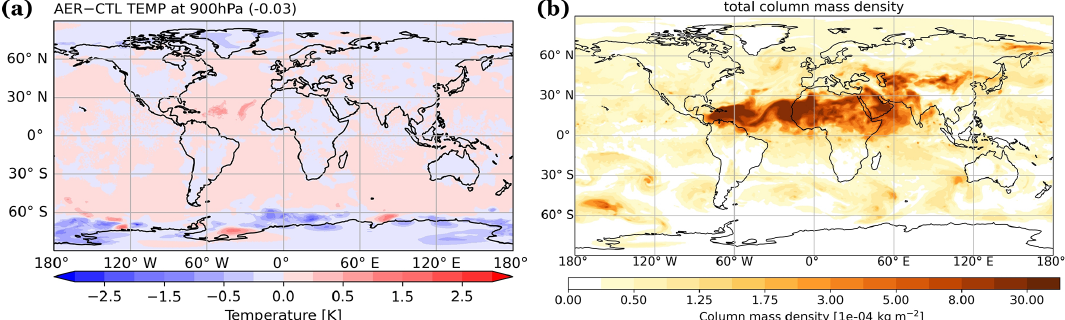
Figure 5. (a) The differences (AER − CTL) of analyzed temperature (K) at 900hPa and (b) the corresponding aerosol column mass density (kgm − 2 ) from MERRA-2 at 12:00Z on 22 June 2020.